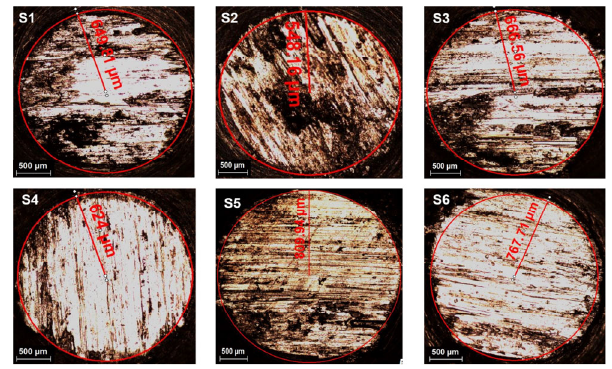
Table 3 Calculated roughness parameters after short test for pin